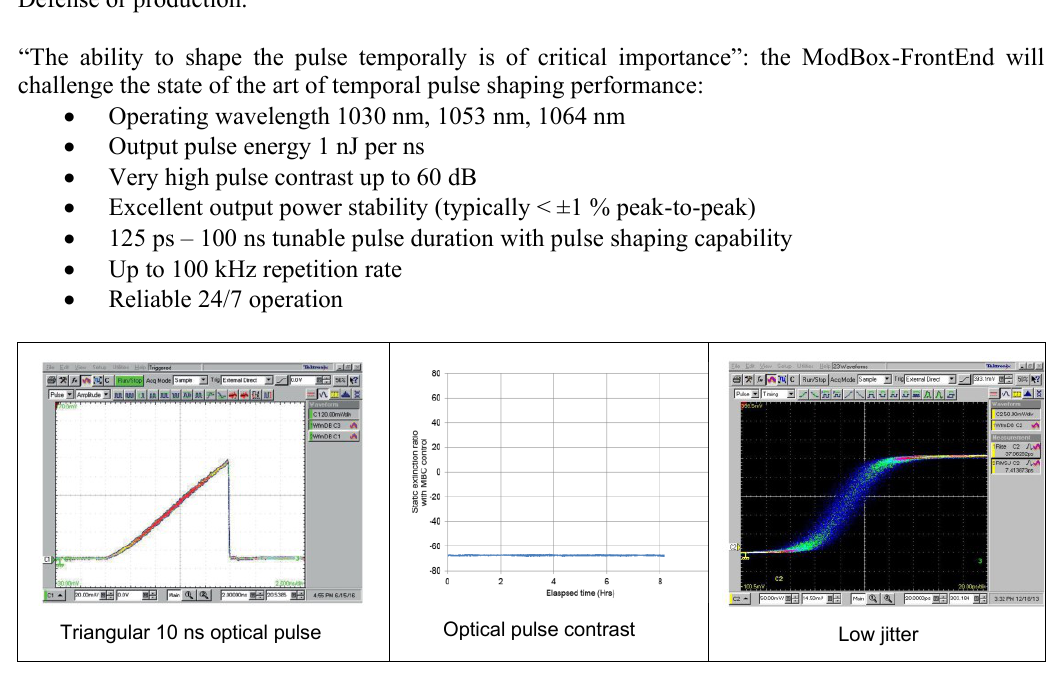
Fig. 1 : Pulse Shaping and ModBox optical